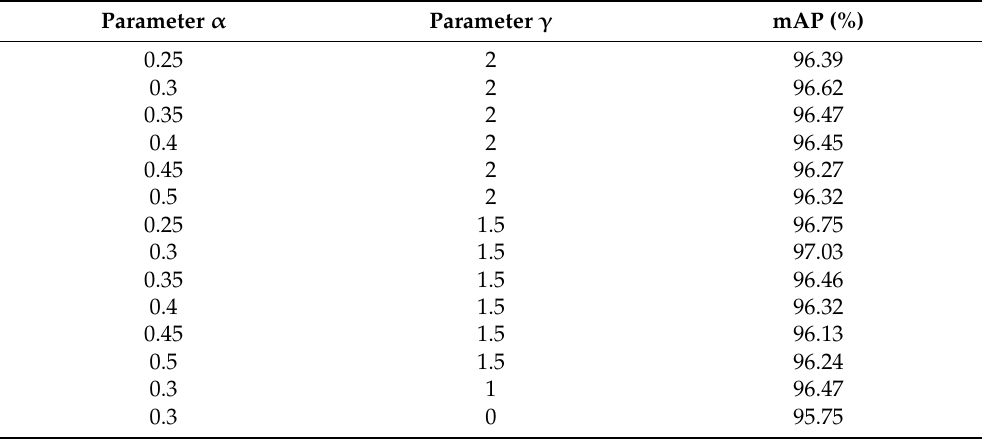
Table 1. Comparison of the mAP of the model under different focal loss